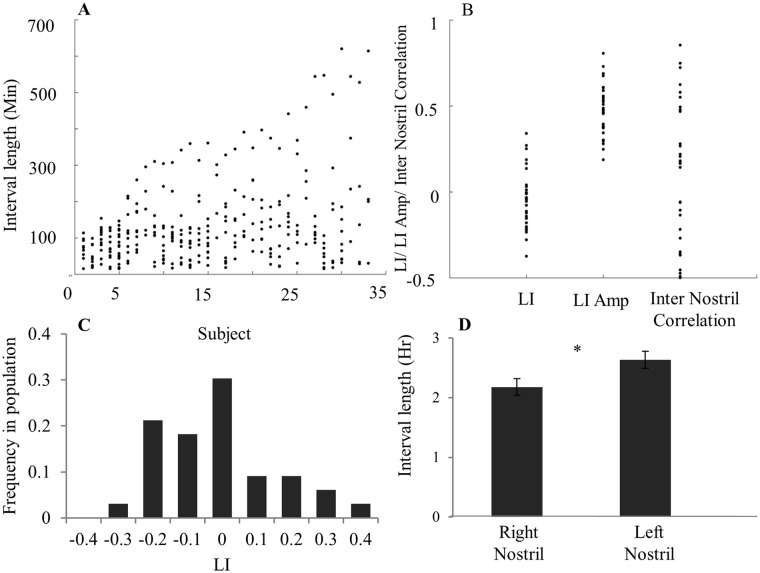
The nasal cycle was highly variable within and across subjects.(A) All intervals across all subjects. X-axis describes each subject (sorted by increasing variability), Y-axis describes all intervals measured for each subject during 24 hours. Each dot is an interval. (B) Range in parameters across subjects. Each dot is a subject. (C) LI distribution across the population. (D) Mean right vs left dominance intervals during 24 hours, reflecting a small but significant tendency to spend more time in left dominant intervals than in right dominant intervals. Error bars are SE.